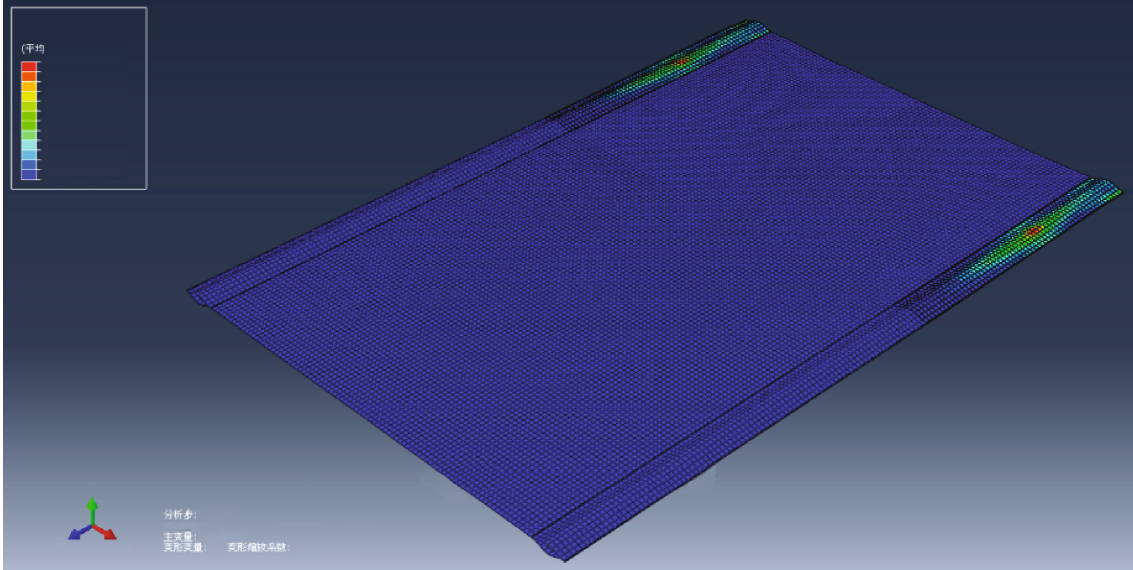
Figure 15: Con fi guration after the press fl attening process.